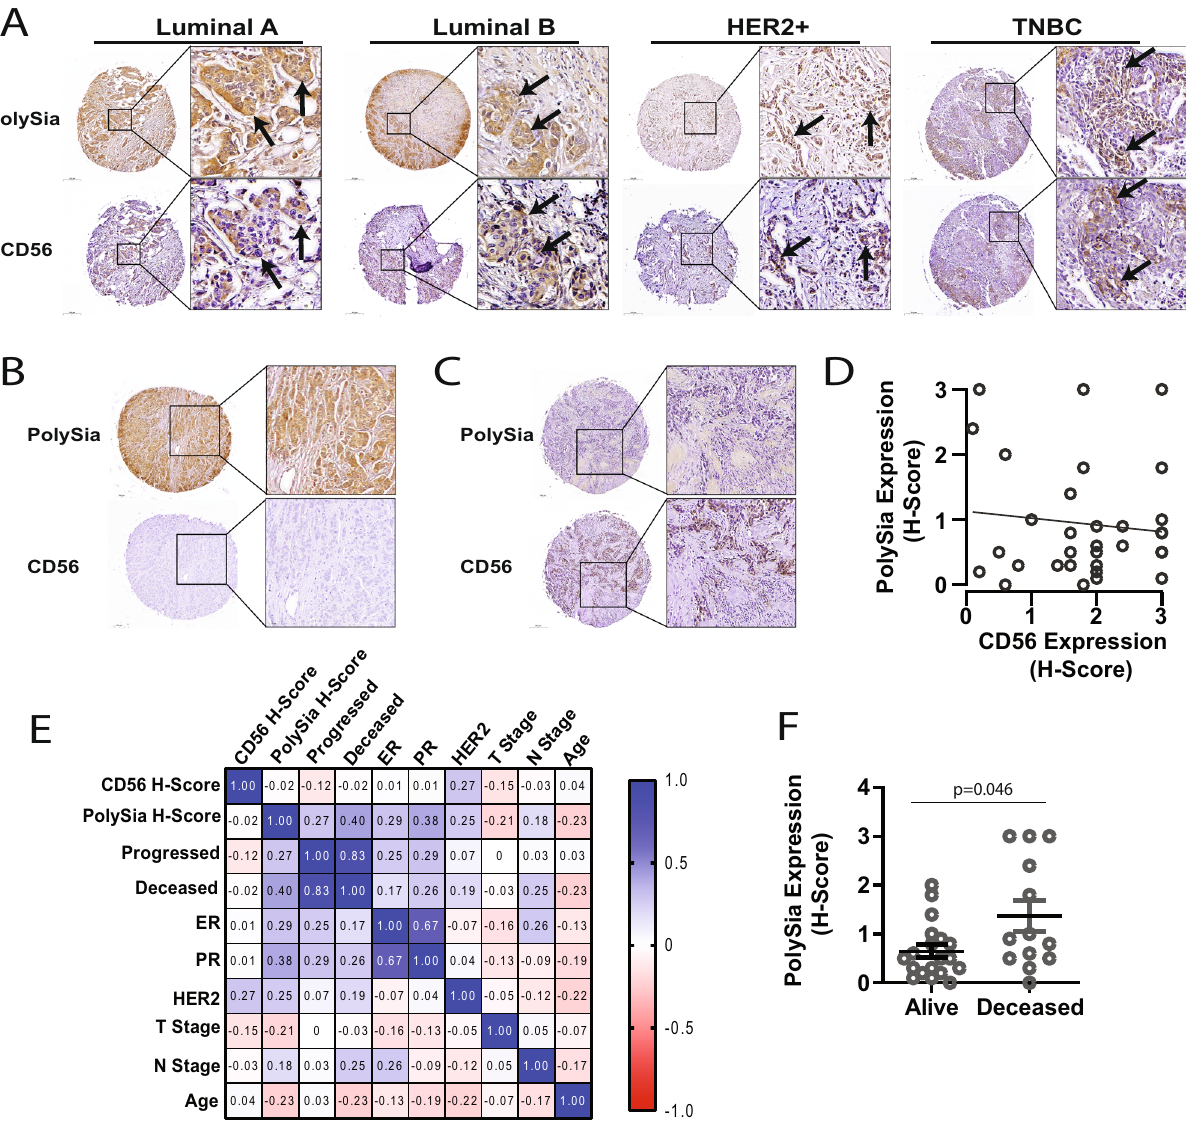
Fig. 5 PolySia and CD56 expression in primary breast tumors. A – C Immunohistochemical staining of polySia (top row) and CD56 (bottom row) in each panel in breast cancer tissue. Arrows point to clusters of cells positive for polySia and CD56. Representative images are shown alongside higher magni fi cation insets from the same core. Scale bar = 200 µm (cores), or 50 µm (insets). D Correlation between polySia expression levels plotted relative to CD56 expression levels for each matched tissue core ( n = 32; gray line: regression line). Pearson correlation test and simple linear regression test. E Correlation matrix of all clinical data and polySia and CD56 expression ( n = 32). Color map represents correlation strength between each data set; represented as positive (blue) or negative (red). Pearson R values are indicated in each box. F PolySia expression levels categorized based on disease speci fi c patient outcome (Alive [ n = 19], Deceased [ n = 13]). ±SEM, unpaired t